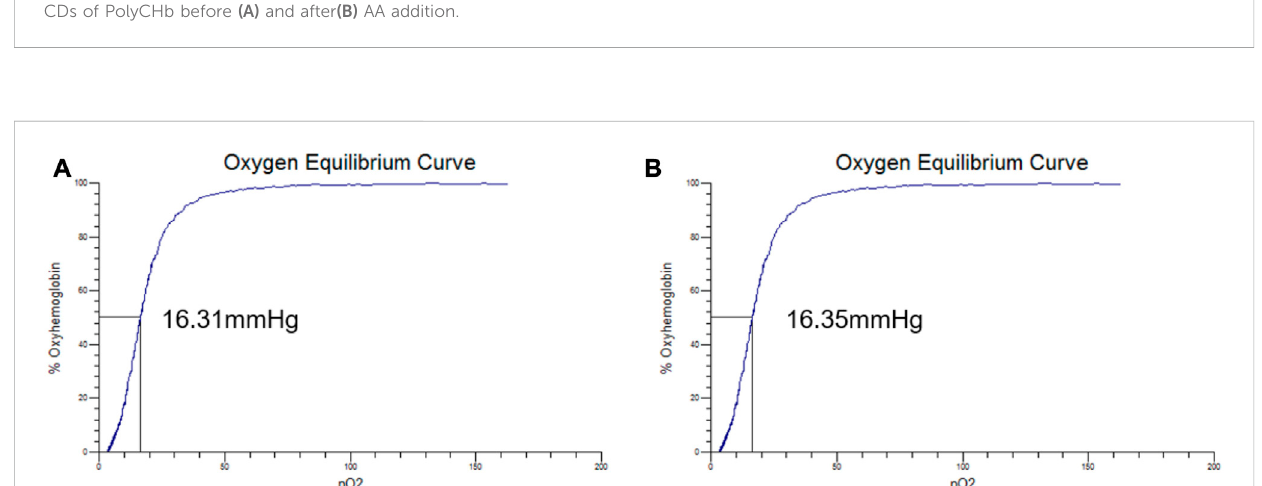
FIGURE 2 The oxygen equilibrium curve of PolyCHb, (A) , before AA addition, (B) , 72 h after AA addition.